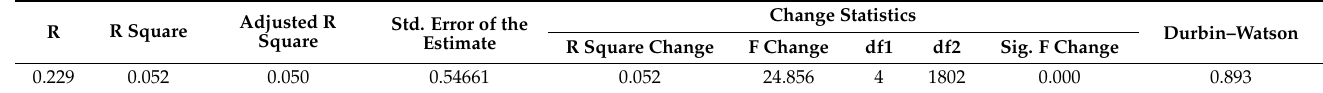
Table 8. AGP model summary.